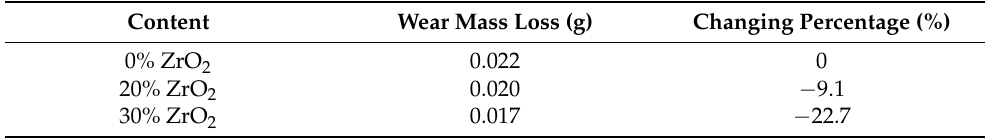
Table 4. Wear mass loss of NiCrAlY-ZrO 2